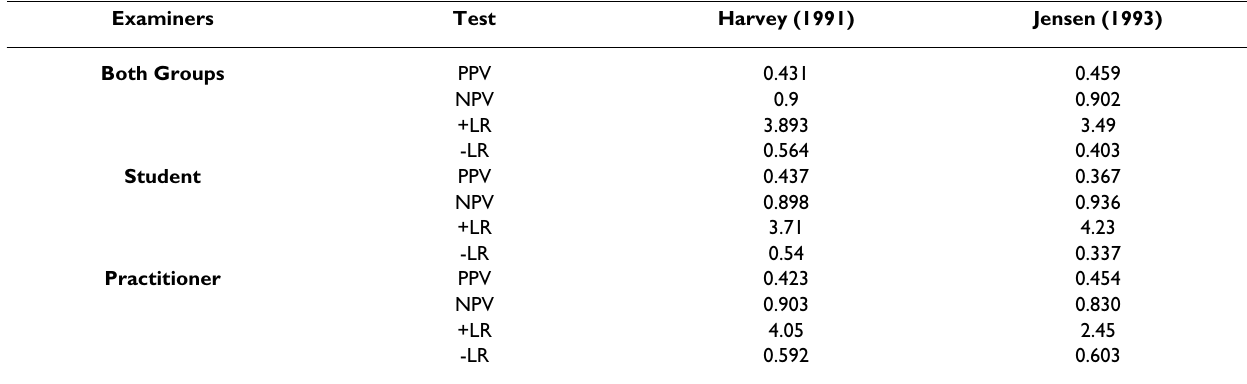
Table 5: Statistical analysis for Motion Palpation Studies using students and experienced practitioners